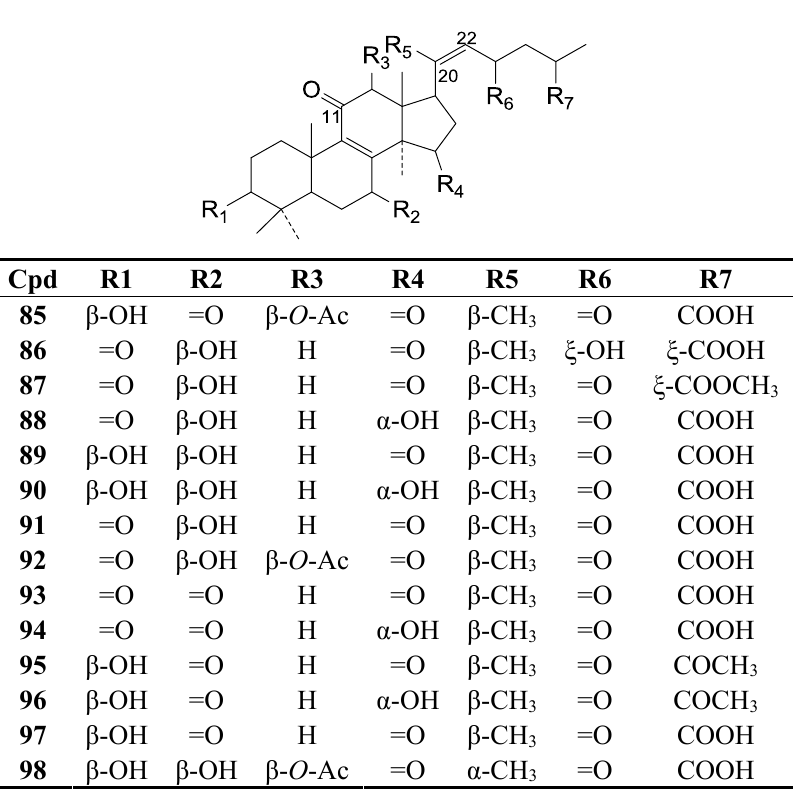
Figure 5. Structures of compounds 85 – 98